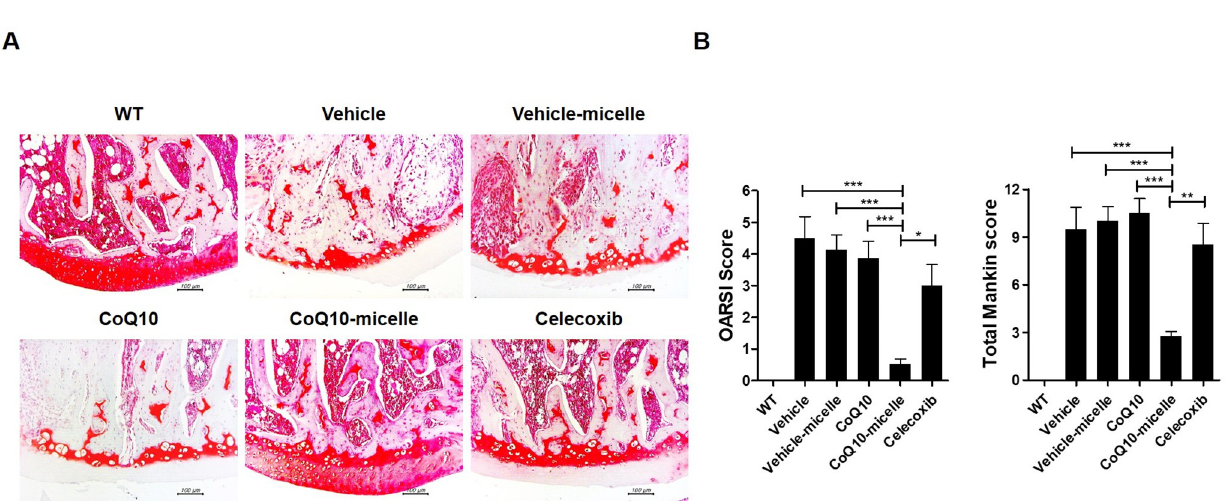
Fig 4. CoQ10-micelles protected against cartilage destruction during OA progression. (A) Safranin-O staining was used to evaluate cartilage destruction in a WT group, a vehicle group, a CoQ10-micelle group, and a celecoxib group (N = 3 per group). (B) The bar graphs show the average OARSI (left) and Makin (right) scores. Data are shown as means ± S.E.Ms. Statistical significance was assessed using the Bonferroni test. � p <